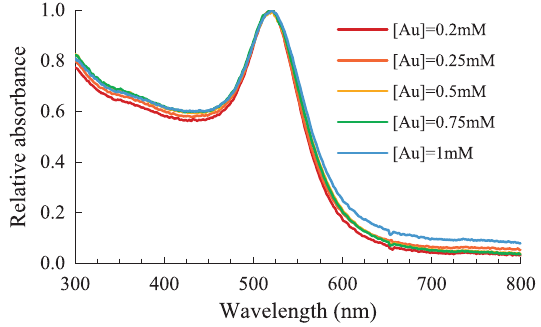
Fig. 9 UV-visible spectra of AuNPs samples synthesized with specific initial gold chloride concentration. (System: